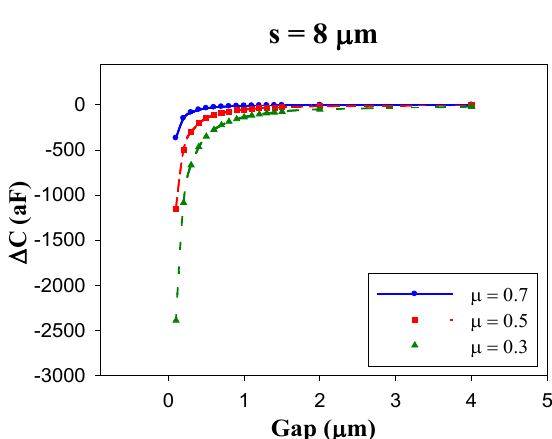
Figure 7. Scheme of the mesh size distribution. Micromachines 2015 , 6 , page–page